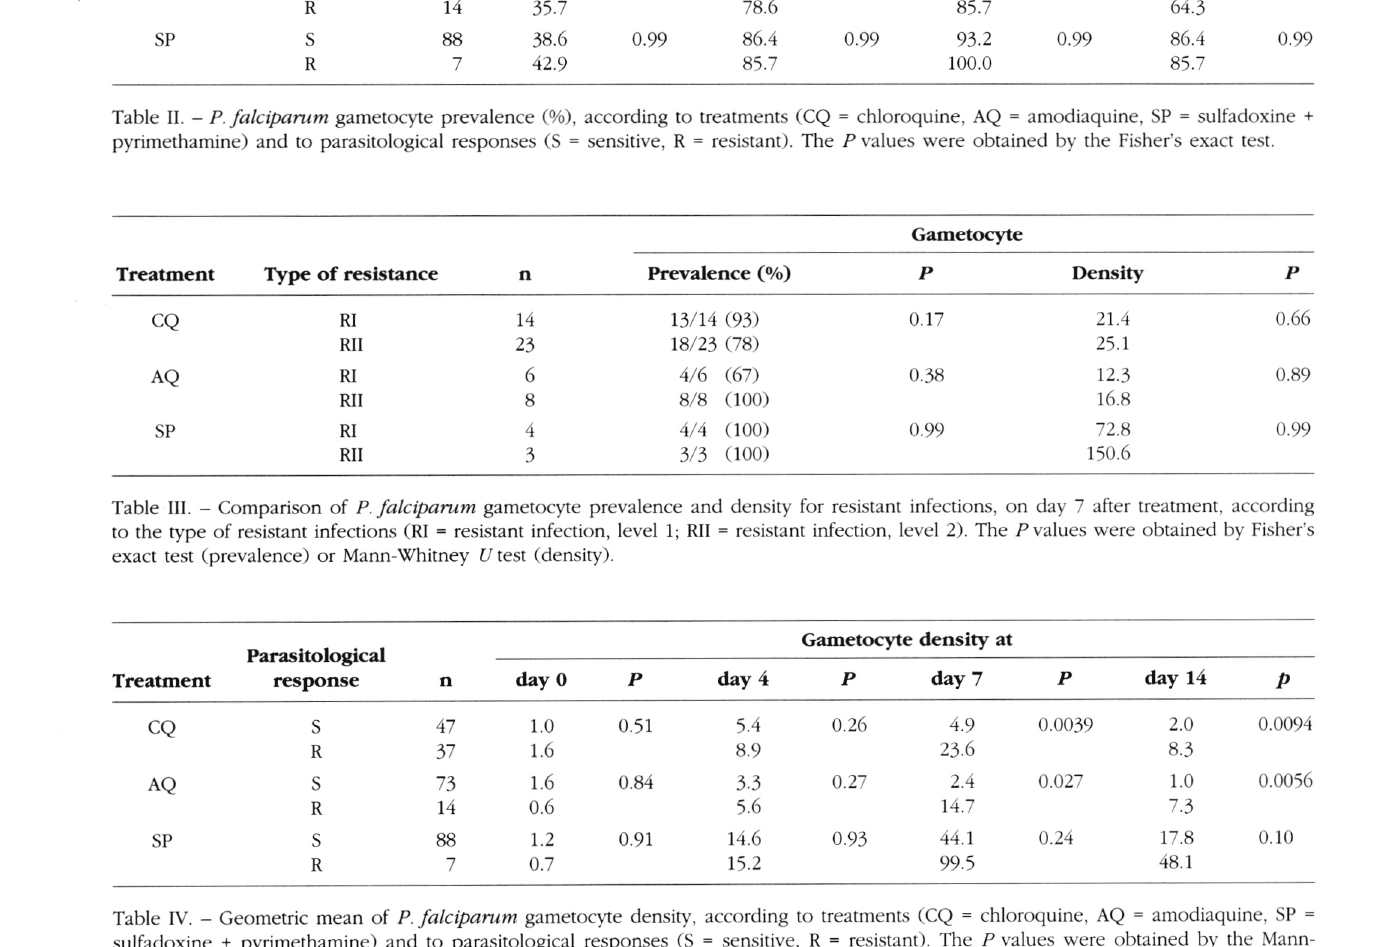
Table IV. - Geometric mean of P. falciparum gametocyte density, according to treatments (CQ = chloroquine, AQ = amodiaquine, SP = sulfadoxine + pyrimethamine) and to parasitological responses (S = sensitive, R = resistant). The P values were obtained by the Mann- Whitney U